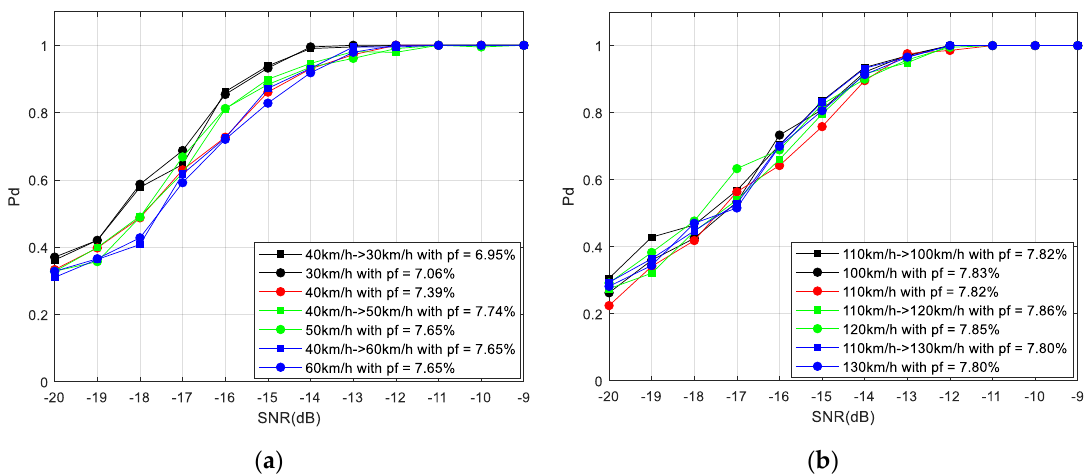
Figure 4. Generalization ability to different velocities, where “a km/h->b km/h” denotes signals at a speed of b km/h to be tested in a well-trained network over signals at a speed of a km/h. ( a ) Detection performance under urban environment; ( b ) Detection performance under highway environment.